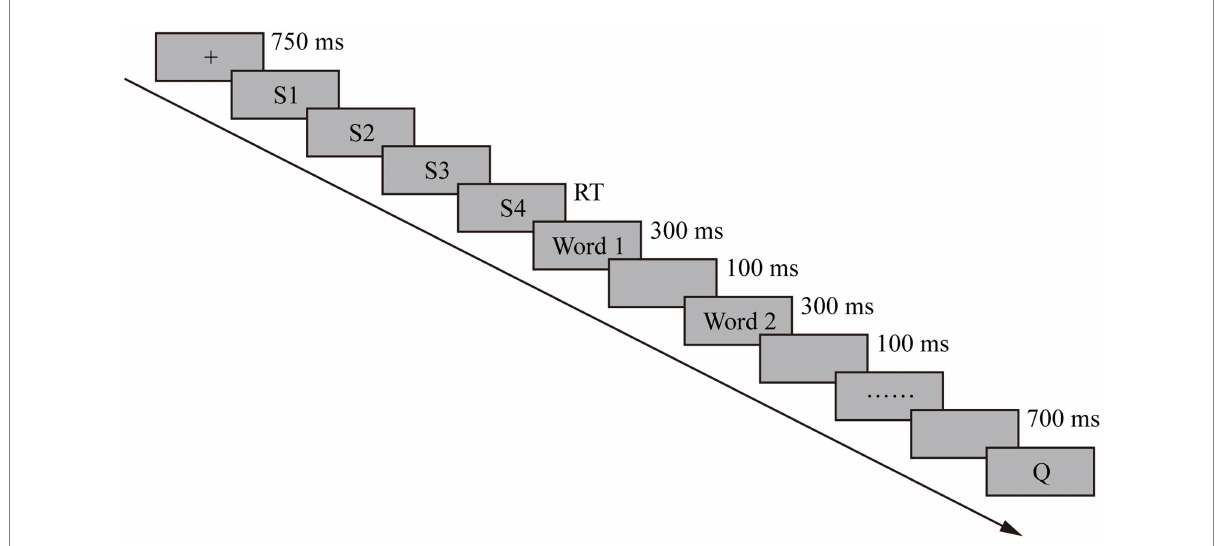
FIGURE 1 An overview of a trial in Experiment